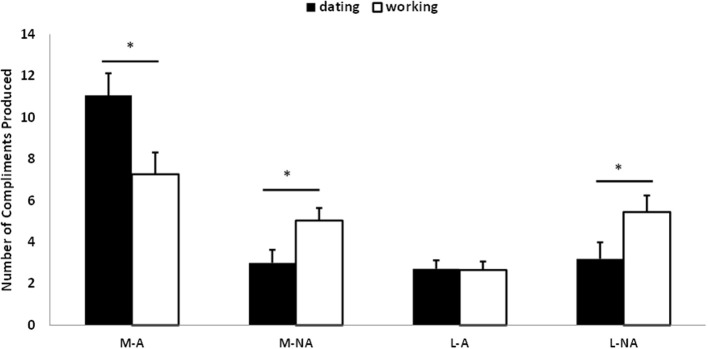
Interactive effect between context and compliment type. A greater number of metaphorical compliments targeting appearance were produced by male subjects in the dating context than in the working context whereas both literal and metaphorical compliments targeting nonappearance were produced more in the working context than in the dating context. No significant difference in literal expression targeting appearance was found between contexts. Bars show means and s.e., *p < 0.05.